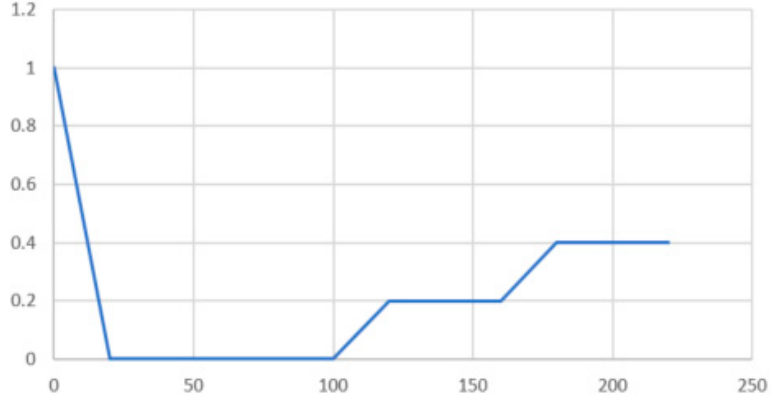
Figure 18. Resilience function depending on time for disruption at Location 2.